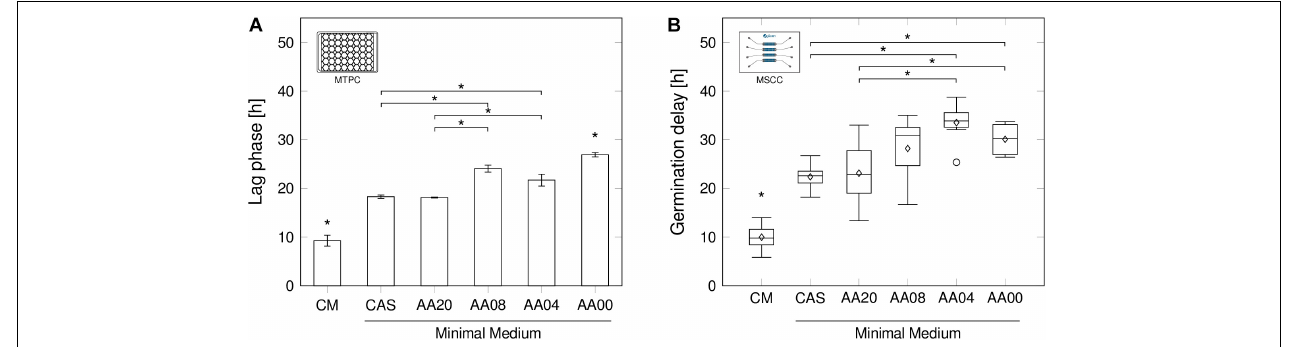
FIGURE 3 | Lag-phase and germination delay by decreasing medium complexity. (A) Lag-phase durations in shaken MTPC for all six medium conditions. Error bars calculated from n = 3 biologically independent replicates. (B) Germination delays determined by MSCC in n ≥ 6 cultivation chambers. Box plot annotation identical to Figure 2D . Determination methods for lag-phases and germination delays are provided in the methods section. Significant differences ( p < 0.05) are indicated by an asterisk ( ∗